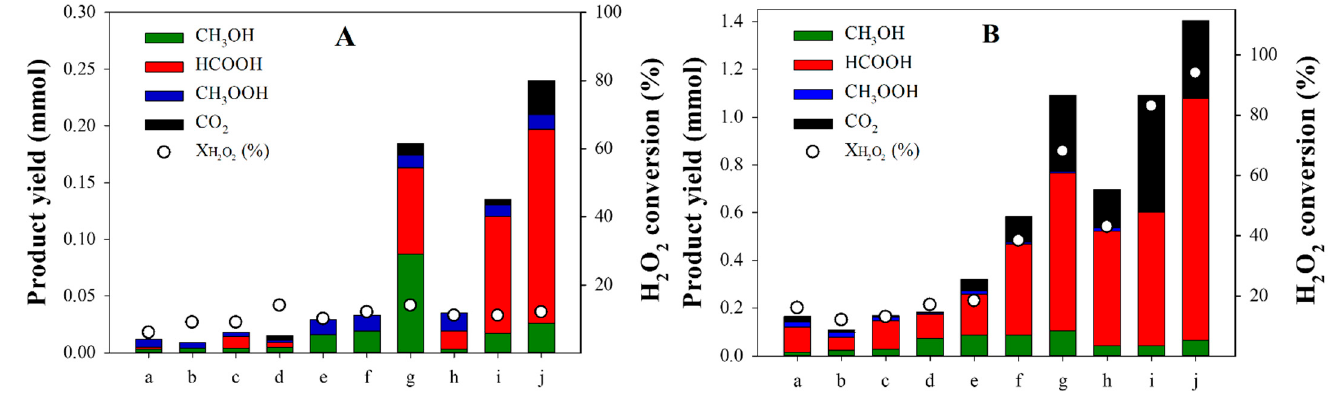
Figure 4. Partial oxidation of methane over H-ZSM-5 (a), 1.12%Cu/ZSM-5(SIE) (b), 0.99%Cu/ZSM- 5(WI) (c), 1.20%Cu/ZSM-5(IE) (d), 0.54%Cu-0.56%Fe/ZSM-5(SIE) (e), 0.55%Cu-0.46%Fe/ZSM-5(WI) (f), 0.56%Cu-0.30%Fe/ZSM-5(IE) (g), 1.13%Fe/ZSM-5(SIE) (h), 1.05%Fe/ZSM-5(WI) (i), and 0.94%Fe/ZSM-5(IE) (j). Reaction conditions: 50 mg catalyst, 31 bar methane, 0.277 M H 2 O 2 , liquid volume = 30 mL, reaction temperature = 30 °C ( A ), 50 °C ( B ). Table 2. The fraction of Cu leached after a reaction over Cu/ZSM-5 and Cu-Fe/ZSM-5 catalysts a . Entry